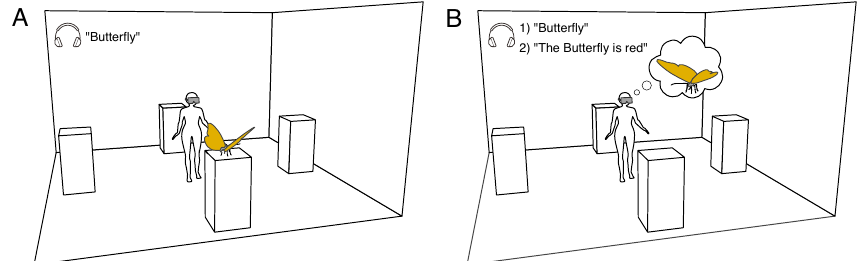
Figure 1. Schematic illustration of the virtual environment ( A ) during encoding and ( B ) during recall. During encoding, each trial started with the title followed by the appearance of the object either in front, to the right, to the left or behind the participants. During recall, participants were cued by the title (1) to visualize the objects they had encoded before (image generation), and they evaluated a statement (true/false) (2) about visual details of the object (image